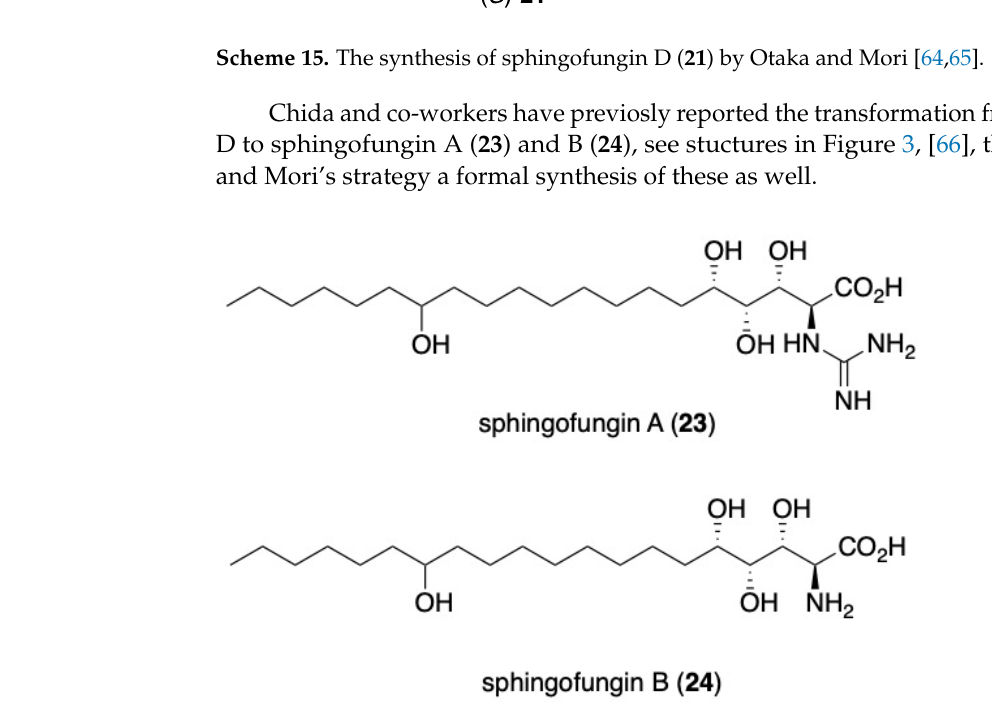
Figure 3. The stuctures of sphingofungin A ( 23 ) and B ( 24 ) [66]. Sugiyama et al. reported the absolute stereochemistry of the ceramide part of achan- thacerebroside A ( 25 ) by preparing the corresponding sphingosine base [67]. In the total synthesis of the cerebroside 25 , an alkyne zipper reaction was used to prepare the lipophlic part of the structure, see Scheme 16. KAPA was prepared from KH and APA, and the reaction was carried out in a solvent mixture of diethyl ether and hexane to give the desired terminal alkyne in 73% yield [68].